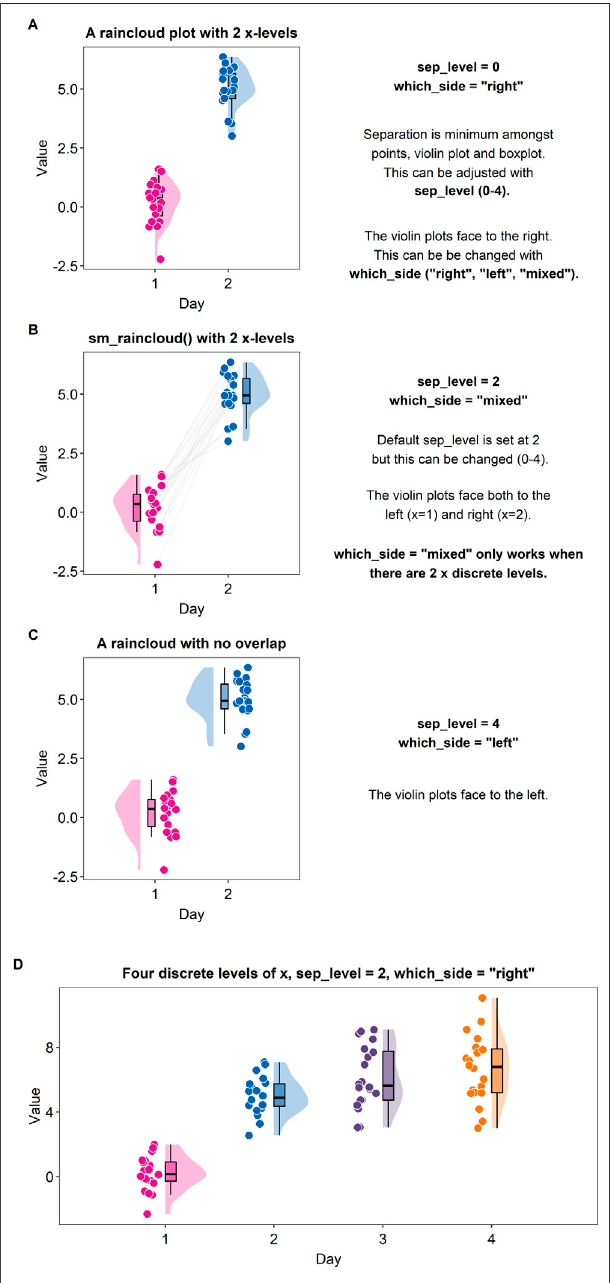
FIGURE 6 | “ which_side (cid:1) “ left ”” . Also, the halved violin plots, boxplots and the jittered individual data do not overlap. There is more separating distance than the plot in panels A and B because the separation level has been speci fi ed to 4, i.e., “ sep_level (cid:1) 4 ” . (D) A raincloud plot with four discrete